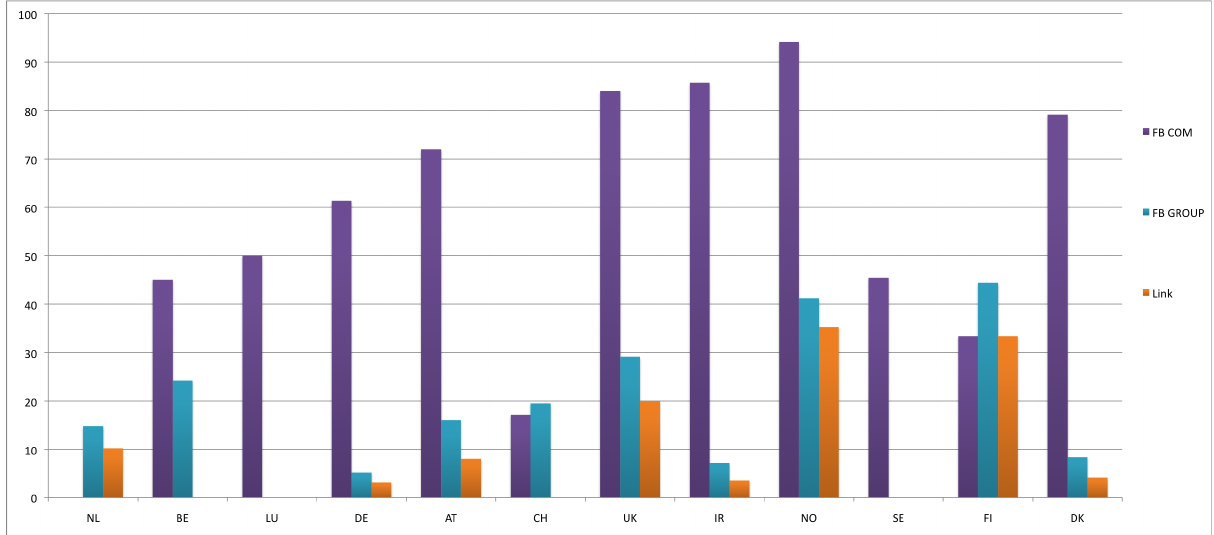
Figure 1. Percentage of Facebook company profiles (FB COM), group pages (FB GROUP), and links (Link) to a Facebook account on hospital websites at T3 (April to July 2011). NL = the Netherlands, BE = Belgium, LU = Luxembourg, DE = Germany, AT = Austria, CH = Switzerland, UK =